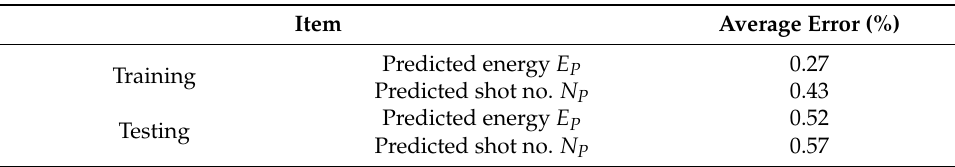
Table 5. Average error of training and testing for the